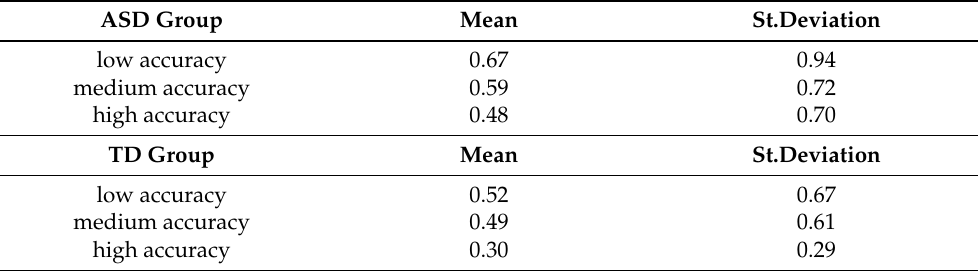
Table 9. Mean per-word tracking time (in seconds), and standard deviation, for 3 ranges of compre- hension accuracy (low accuracy = 1st quartile; medium accuracy = 2nd, 3rd quartiles; high accuracy = 4th quartile), aggregated by reading modalities for ASD and TD children. ASD Group Mean